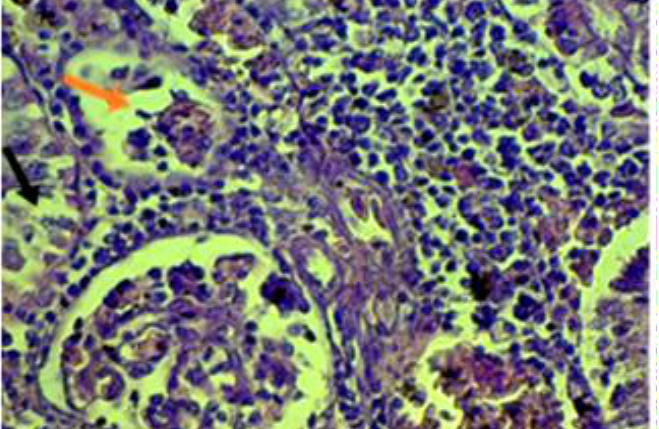
Figure 5. Histopathological section of liver shows thickening and congestion of central vein ( ) with focal aggregation of melanomacrophages beside the central beside the central vein (